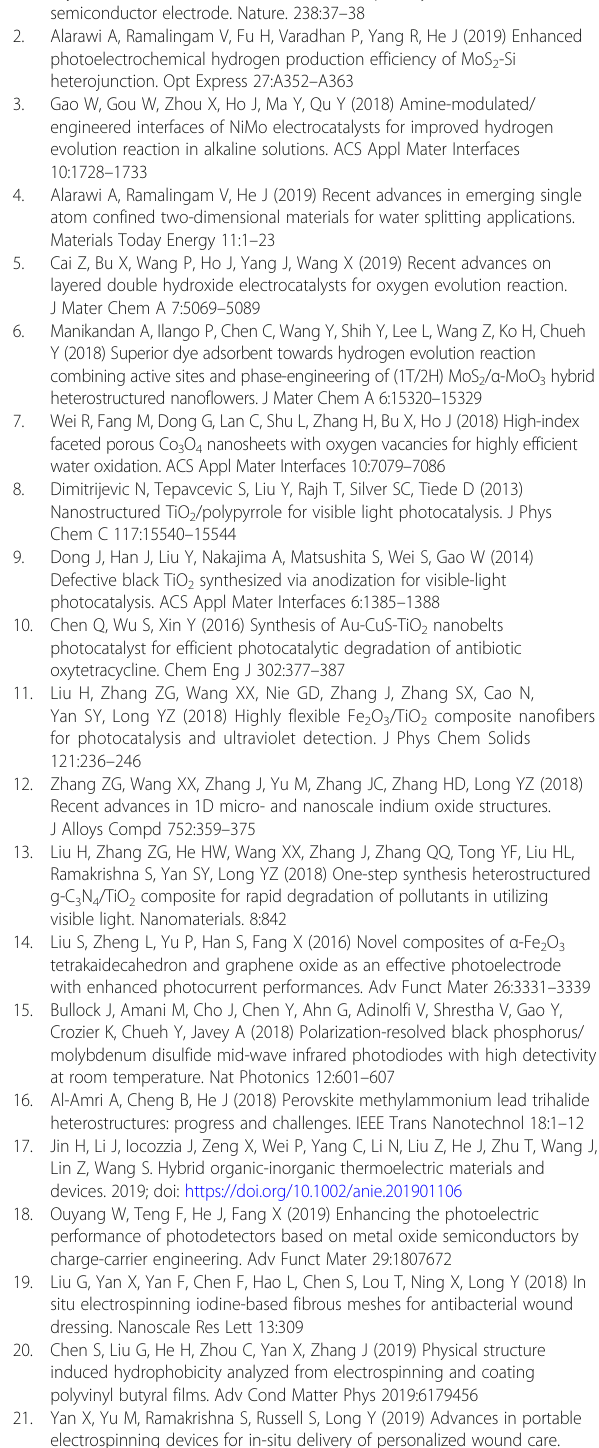
Additional file 1: Figure S1. The optical photograph of the flexible CuS/TiO 2 /PVDF fibers. Figure S2. The spectrum of LED white light used in the experiment. Figure S3. XPS survey spectrum of the CuS/TiO 2 /PVDF fibers. Figure S4. The pseudo-first-order kinetics process of the as-prepared samples on photodegradation of RhB. Figure S5. Control experiments without and with radical scavengers for TiO 2 /PVDF (a) and CuS/TiO 2 /PVDF (b) fibers. (DOCX 1495 kb) Abbreviations CuS: Copper sulfide; DRS: Diffuse reflectance spectra; MB: Methyl blue; MO: Methyl orange; PL: Photoluminescence spectra; PVDF: